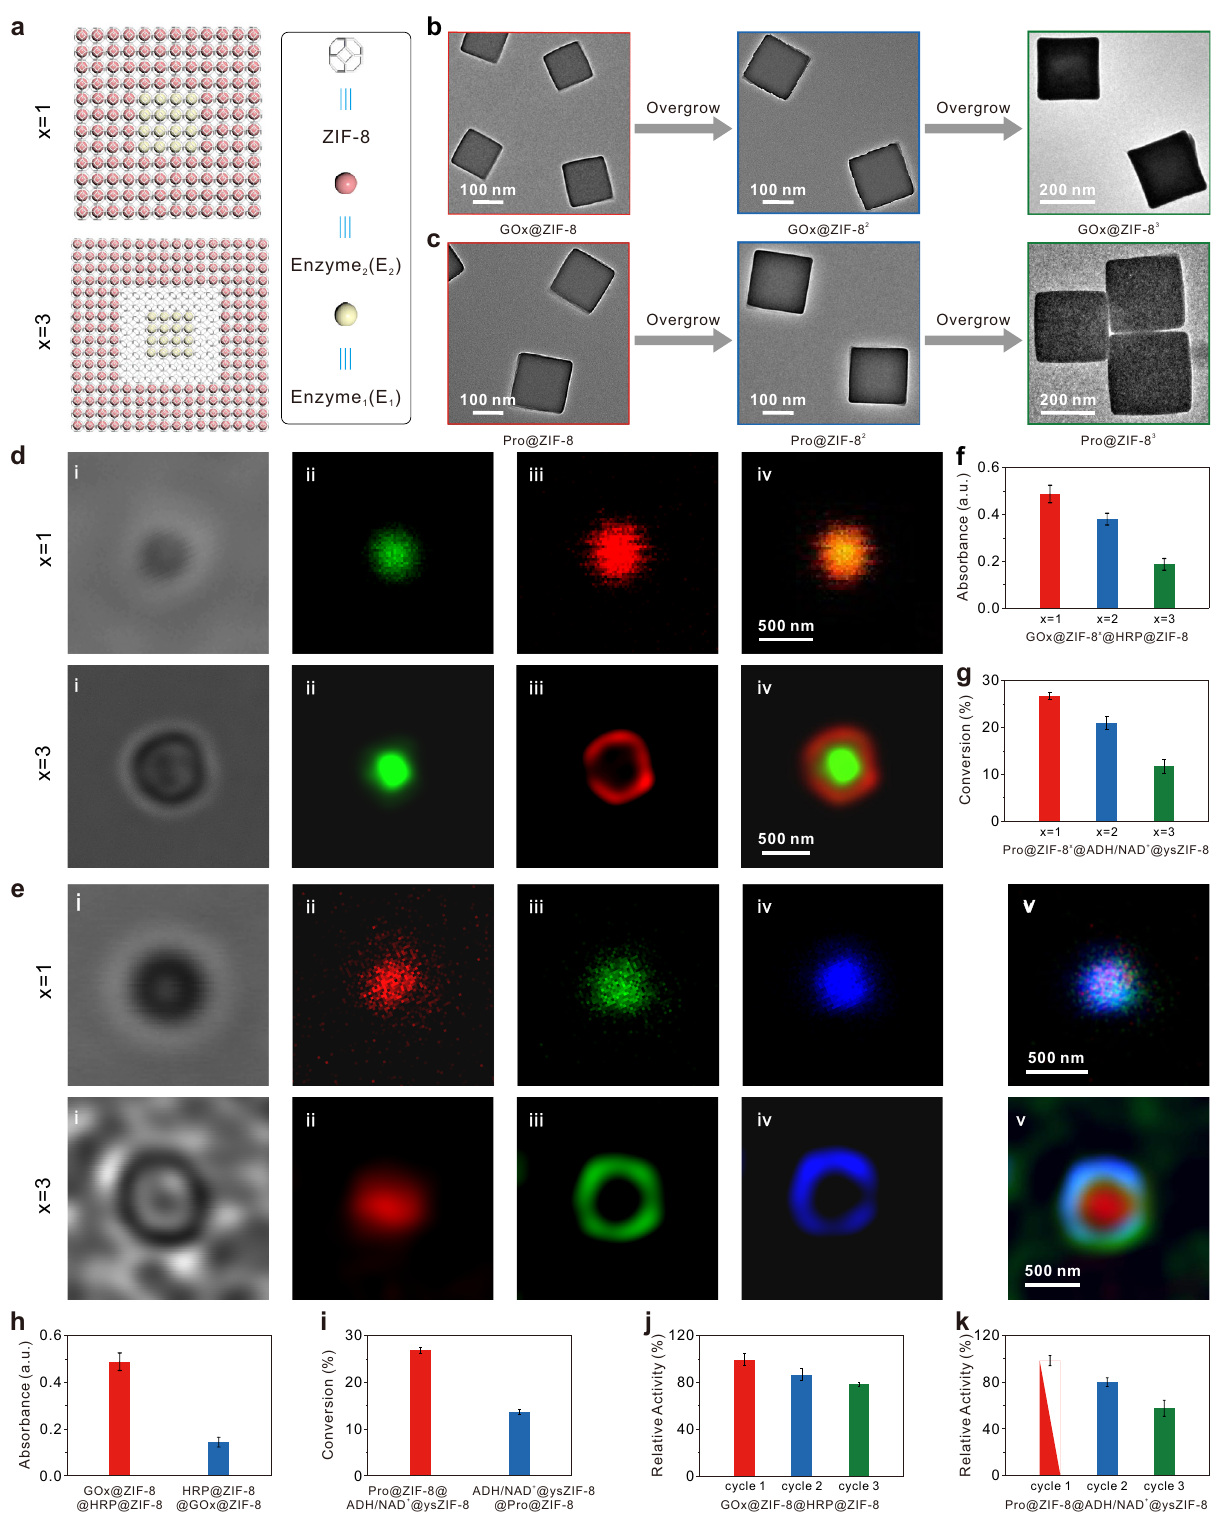
labeled HRP (iii); the merged image con fi rmed the successful con fi nement of GOx and HRP in multi-shelled ZIF-8 (iv). The colocalization revealed a slightly larger spot of RhB-labeled HRP than FITC-GOx, however, the limited spatial resolution of fl uorescence confocal microscopy prevents more-precision loca- lization. Only when the spacing between GOx- and HRP-loaded